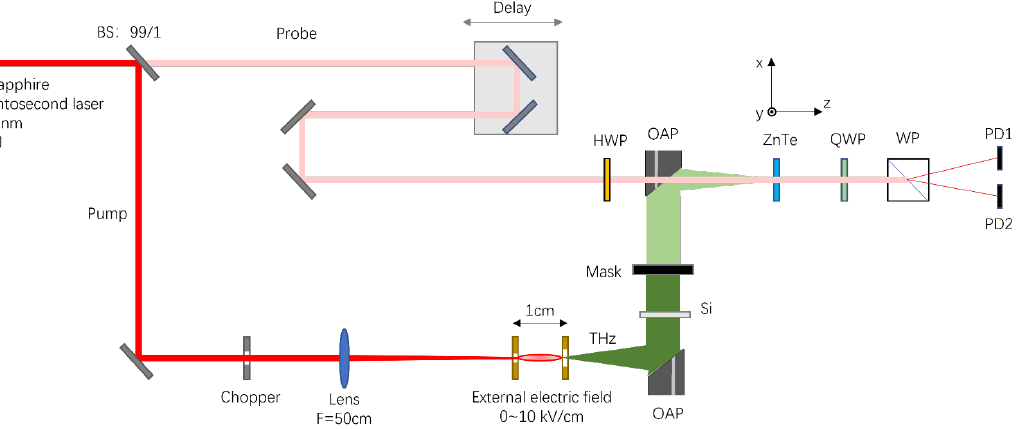
Figure 4. Schematic diagram for the experimental setup: HWP, half-wave plate; QWP, quarter-wave plate; WP, Wollaston prism; PD, photodiode detector.